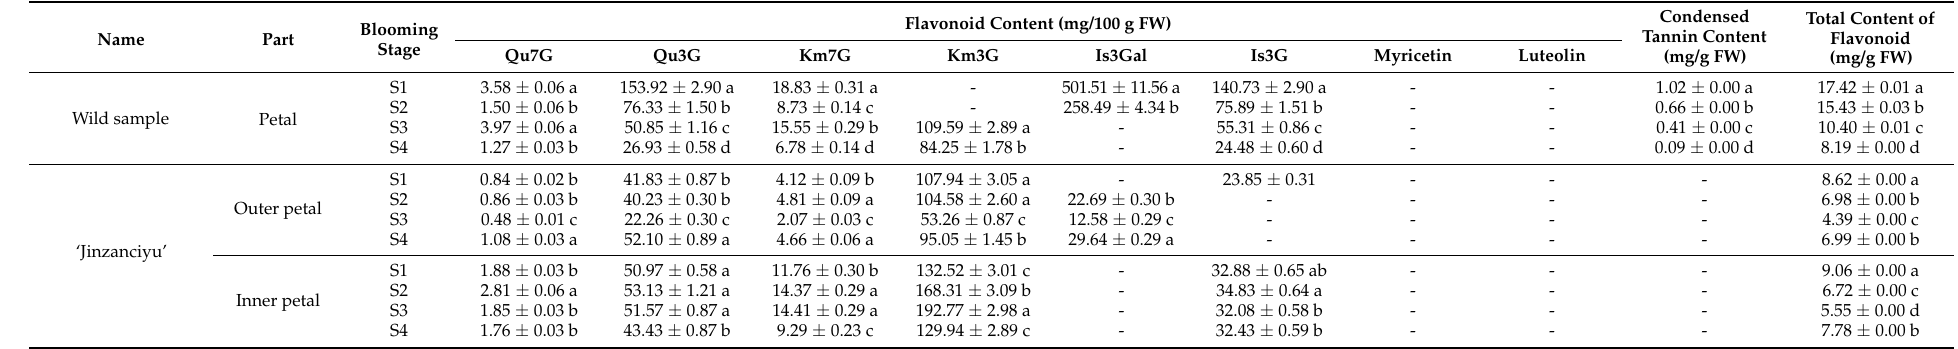
Table 2. Composition and content of flavonoids in herbaceous peony